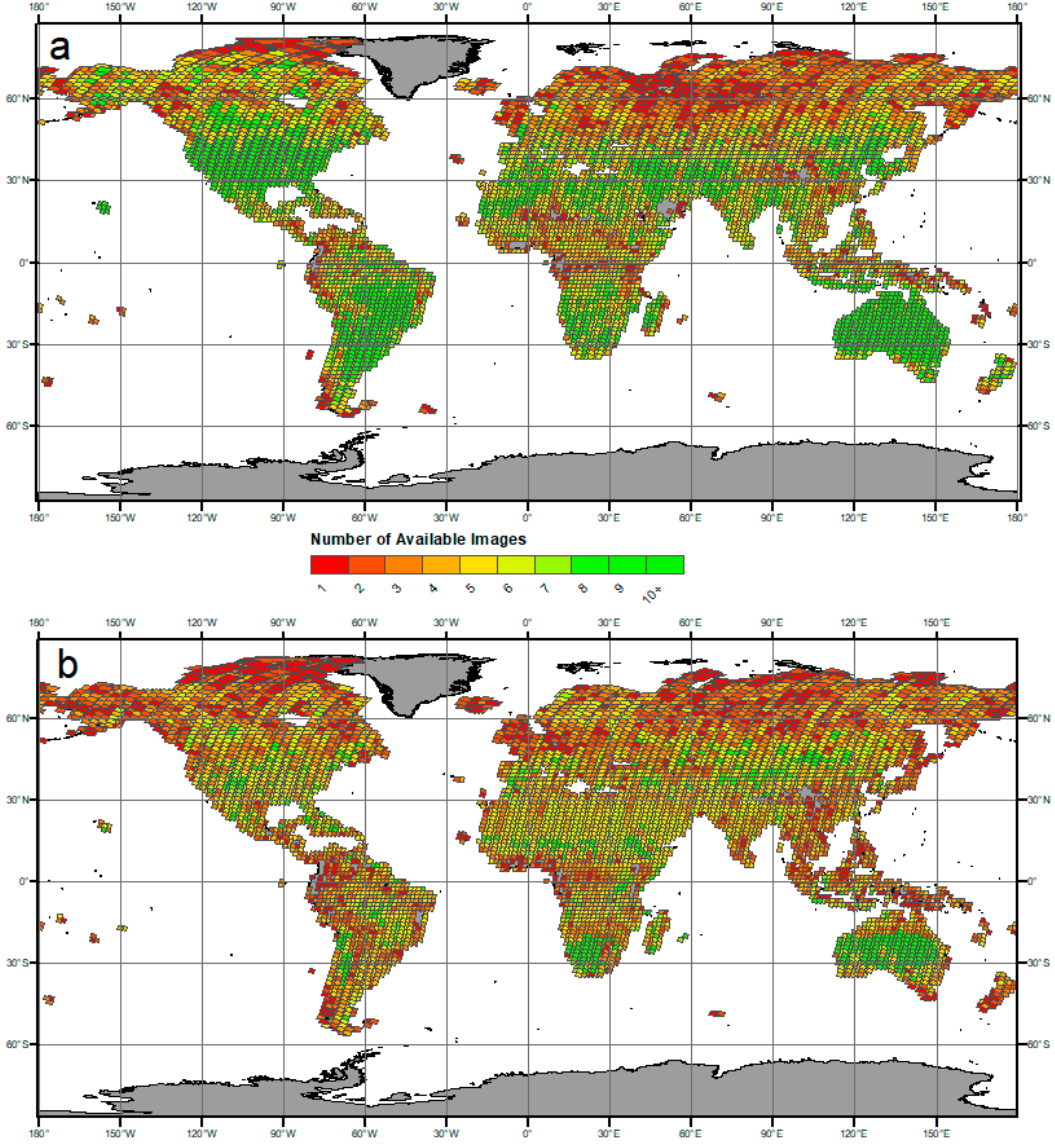
Figure 4. Global coverage of optimal images for ( a ) Landsat 7 Enhanced Thematic Mapper Plus (ETM+) (1999–2003) and ( b ) Operational Land Imager (OLI) (2013–2014). Coverage is generally good with occasional gaps in the tropics and high latitudes due to cloudiness.